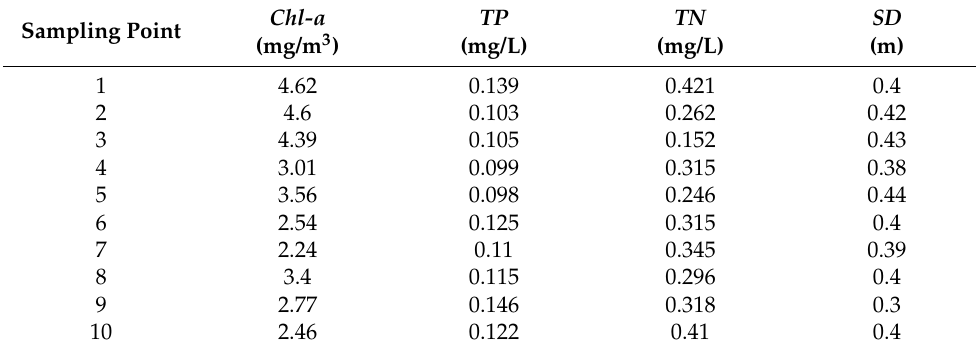
Table A1. Measured water quality parameters of each sampling